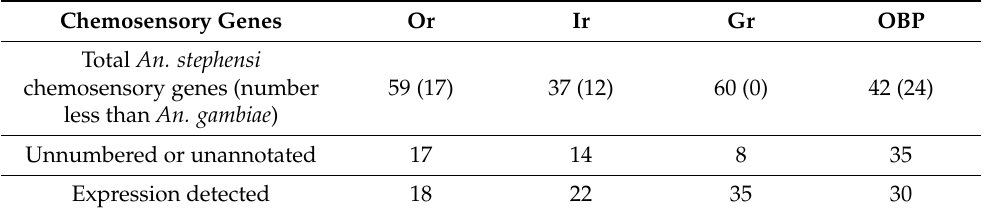
Table 2. An. stephensi Or, Ir, Gr, and OBP genes corresponding to annotated An. gambiae homologs. Chemosensory Genes Or Ir Gr OBP Total An. stephensi chemosensory genes (number 59 less than An. gambiae )